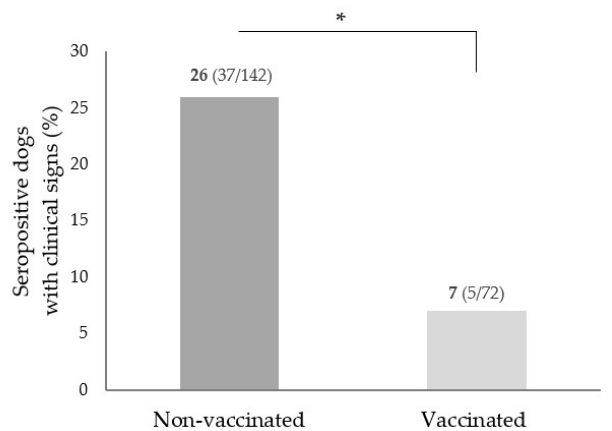
Figure 2. Percentage of seropositive dogs with clinical signs compatible with canine leishmaniosis in both nonvaccinated and vaccinated groups. * p = 0.002